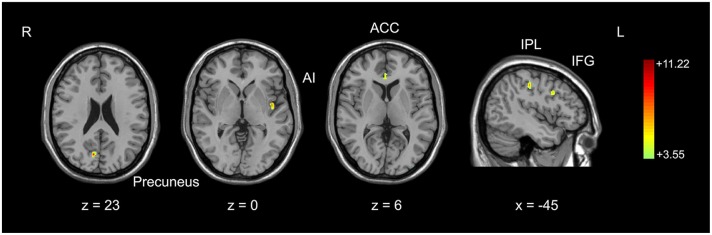
Comparison of gray matter volume between basketball players and novices. Cortical areas with more gray matter volume in basketball players compared to novices was shown. Color scale represents the significant t-values (corrected p < 0.05). L = left; R = right. Abbreviations for brain areas: ACC, anterior cingulate cortex; AI, anterior insula; IFG, inferior frontal gyrus; IPL, inferior parietal lobule.